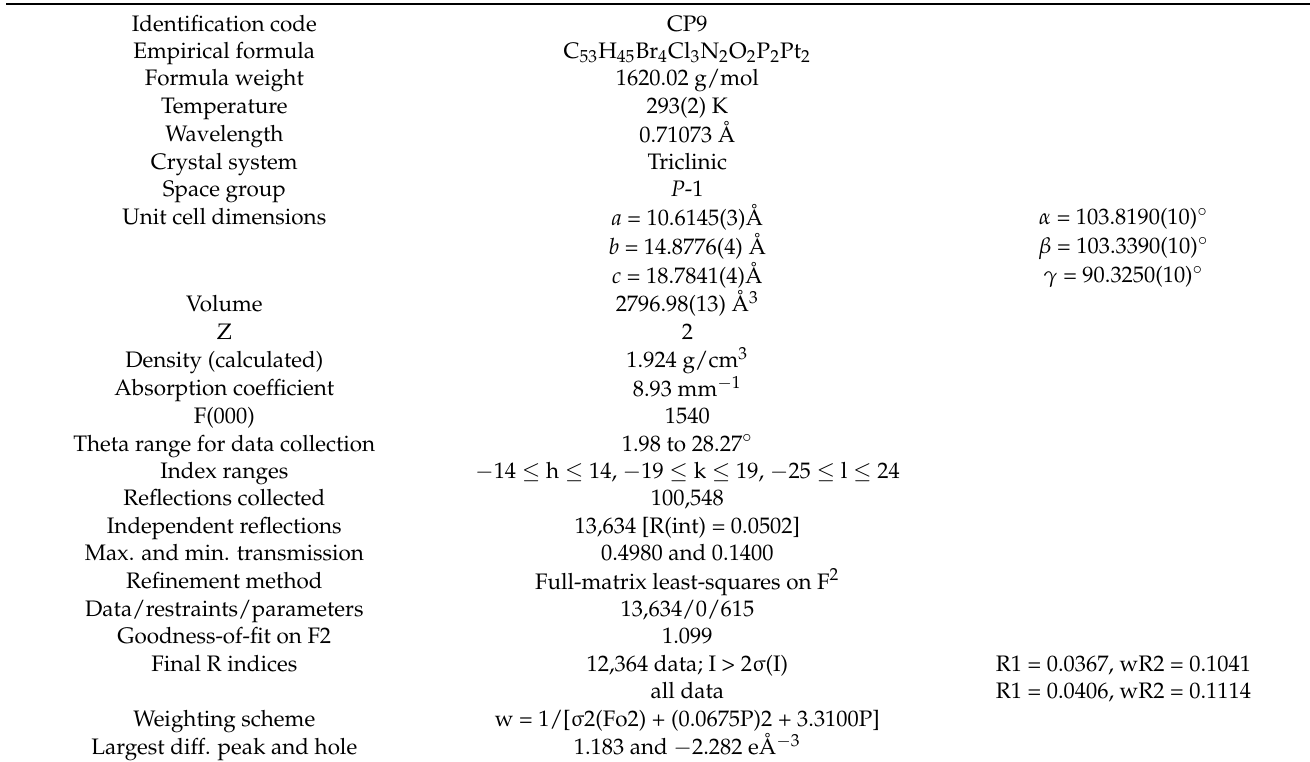
Table 3. Crystal data for cis -[PtBr 2 (PPh 3 )(CNC 6 H 4 OMe)] ( 3